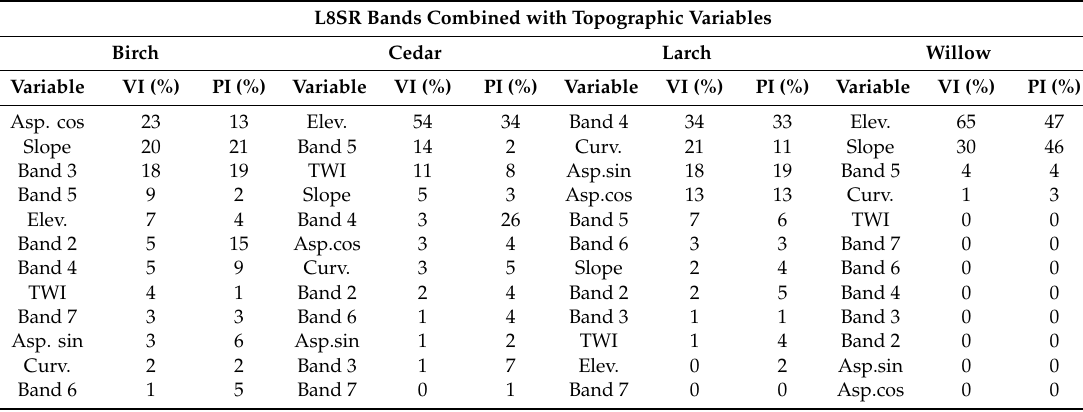
Table 3. Estimates of variable importance of the satellite imagery coupled with topographic variables.